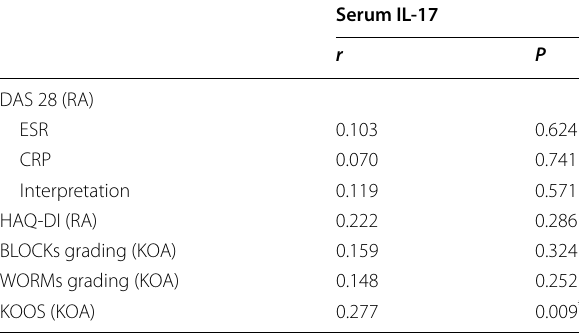
Table 2 Correlation between serum IL‑17 and DAS‑28 and HAQ‑DI in RA patients, and KOOS pain score in early knee OA